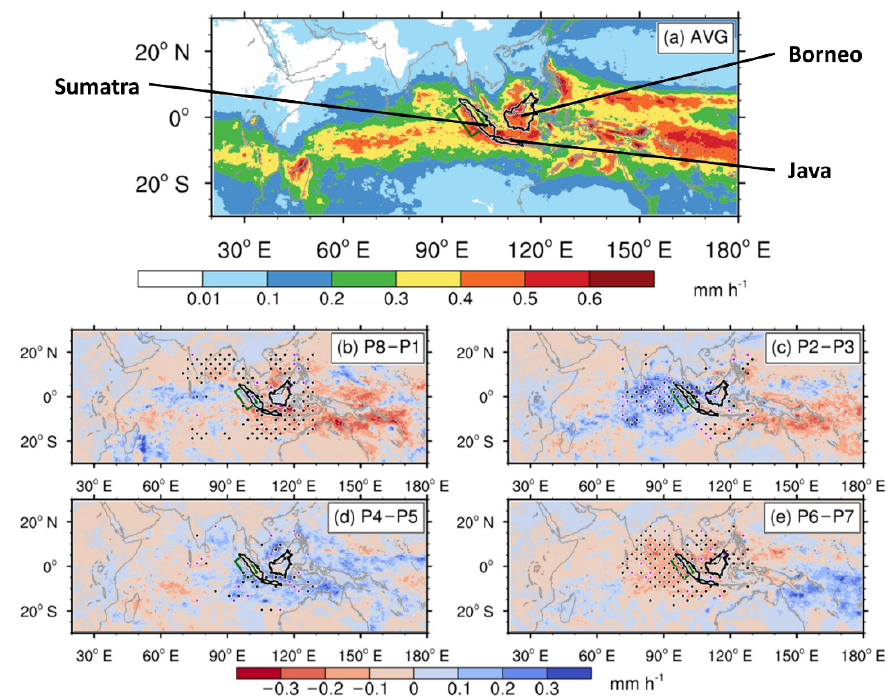
Figure 2. The precipitation rate (mm h − 1 ) ( a ) averaged in DJF 2011–2020 and its anomalies in ( b ) P8–P1, ( c ) P2–P3, ( d ) P4–P5 and ( e ) P6–P7. The black outlines mark the islands of Sumatra, Borneo and Java. The green box at western Sumatra coast marks the analysis region in this paper. The purple and black dots indicate the 90% and 95% confidence at 20° N–20° S, 70° E–130° E, according to the Student’s t-test.